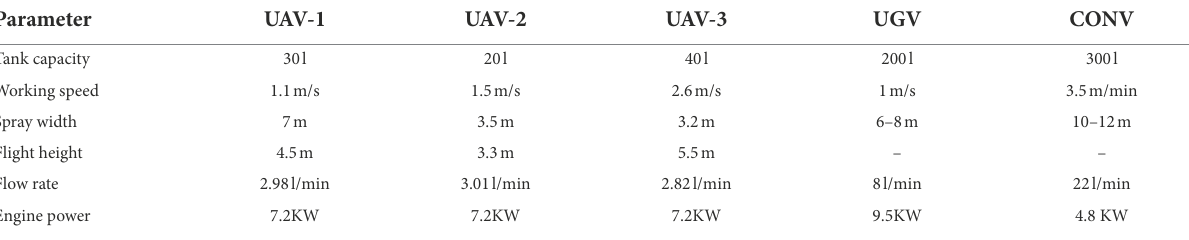
Flow rate Engine